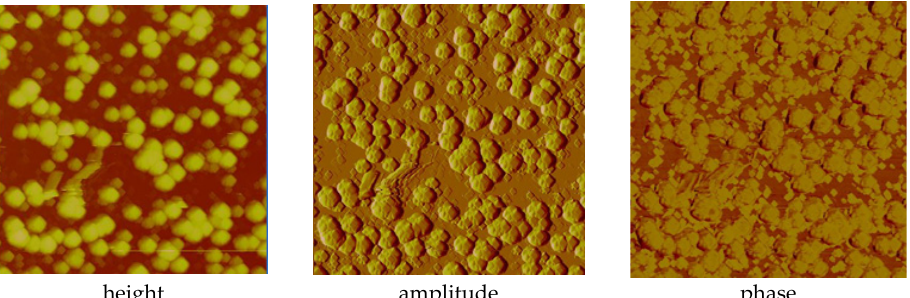
height amplitude phase Figure 25. AFM images of [Cu 2 (EtNH 2 ) 2 (µ-O 2 CC 2 F 5 ) 4 ] ( 2 )/Si, immersion time 30 s. Mag 5 µm, after Figure 25. AFM images of [Cu 2 (EtNH 2 ) 2 ( µ -O 2 CC 3 F 7 ) 4 ] ( 3 )/Si, immersion time 20 s. Mag 5 µ m, after heating.